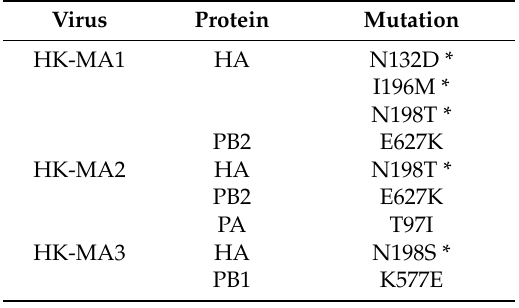
Table 1. Mutations detected in mouse-adapted H9N2